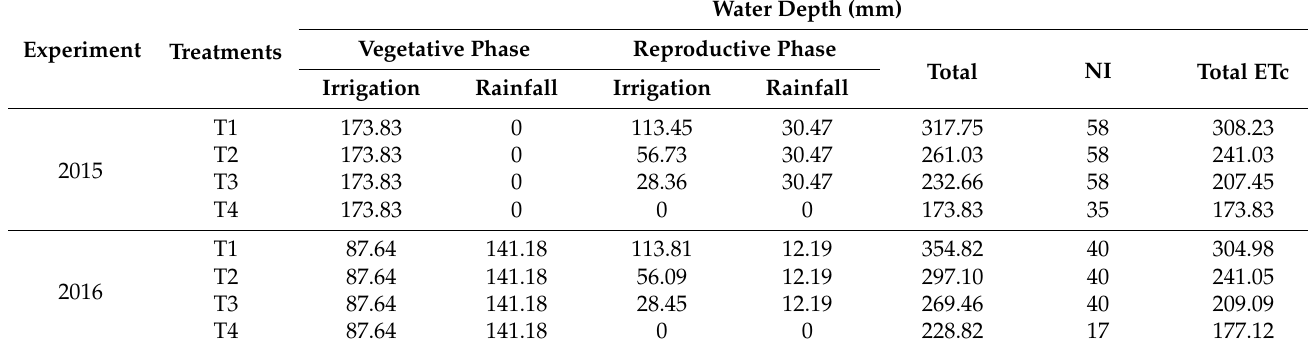
Table 2. Water blade applied before the differentiation of treatments (irrigation + precipitation), water blade applied after the differentiation of treatments (irrigation + precipitation), total water blade during the experiment (total), number of irrigations (NI) and crop evapotranspiration (ETc) in 2015 and